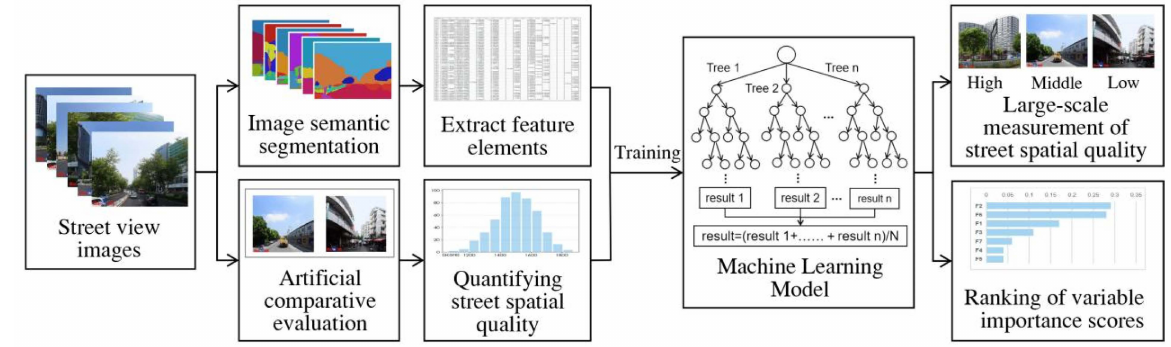
Figure 5. The framework for the street spatial quality